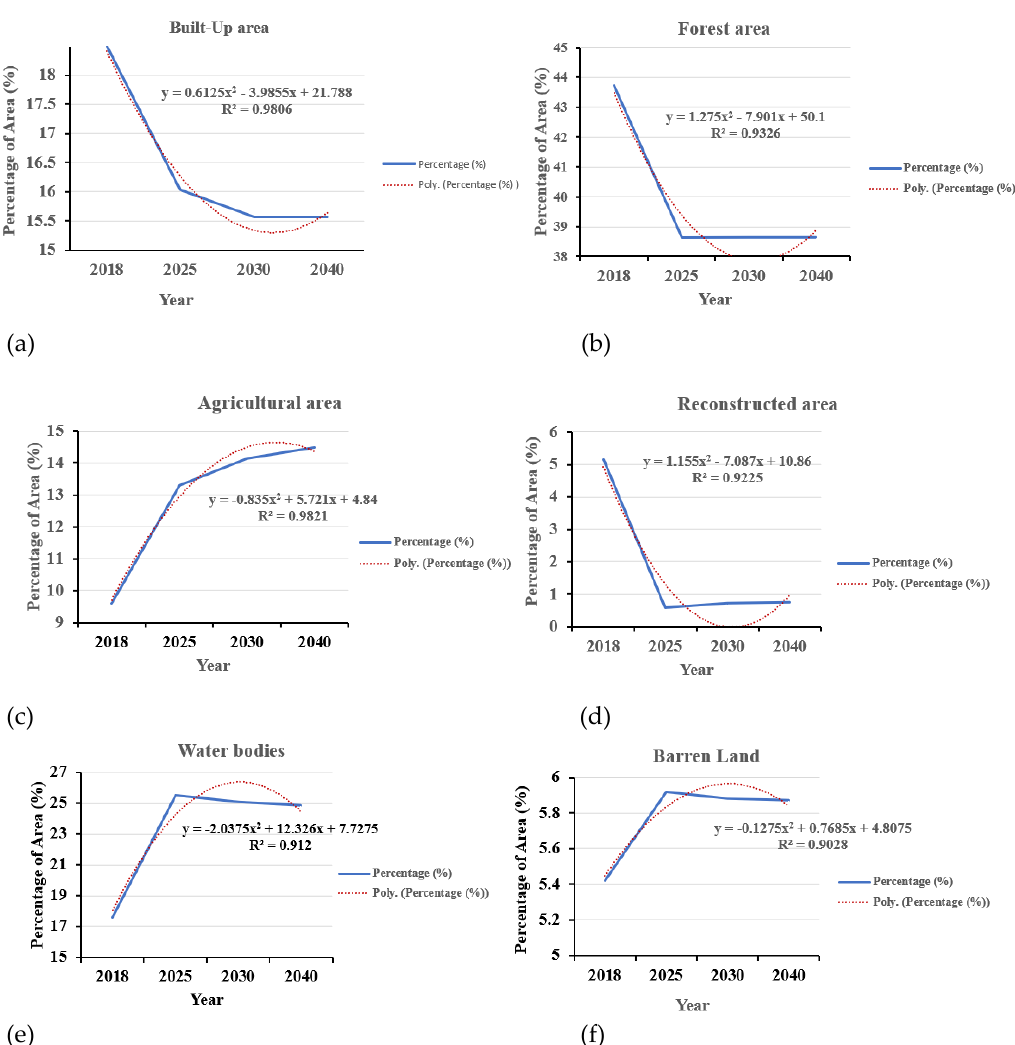
Figure 6. Percentage distribution of FLULC of the DCEN area of SW China from 2018 to 2040. The trends of individual LULC were prepared based on the projected LULC maps of 2018, 2025, 2030, and 2040 by applying a 2nd-order polynomial regression curve with a regression equation and R 2 values; ( a ) BU, ( b ) F, ( c ) AG, ( d ) RA, ( e ) WB, and ( f ) BL. With the above changes, BL also shows the same trend of WB, which is an overall change of − 1 0.37% yr ( R 2 = 0.903) in 2018–2040 (Figure 6f). The overall tendencies of WB suggest that if any high-intensity earthquake occurs in this area, WB will probably migrate or the area may be flooded, and also, the frequency of landslides events may increase due to tectonic influence. To crosscheck FLULCC, we performed a change di ff erence of FLULC based on a similar time interval where in each stage, two earlier images and a recent one (for example, 2018 as the earlier ones and 2025 as the recent one) were considered to study changes. This was performed by the minus operator of the Spatial Analyst toolbar of ArcGIS 10.6 software. The change di ff erence maps in di ff erent time periods are shown in Figure 7a–d, where a light green color represents ‘no change’ and brick red and blue colors represent ‘negative’ and ‘positive’,